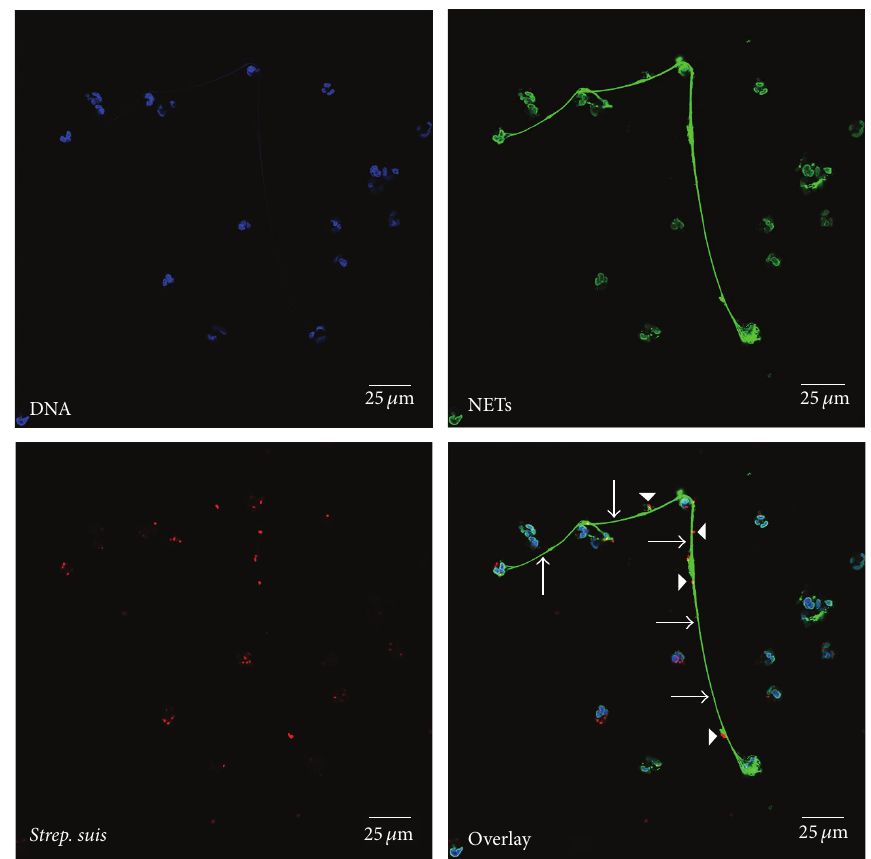
Figure 1: NETs entrapping Streptococcus (Strep.) suis Δ endAsuis Δ ssnA . Immunofluorescence microscopy analysis of NETs released by human neutrophils 4 h after infection with the DNase deletion mutant Strep. suis Δ endAsuis Δ ssnA in vitro [25]. Neutrophils and bacteria were centrifugedonpoly-L-lysine-coatedcoverslipsandthenucleiwerestainedwithHoechst(blue).Furthermore,thesampleswereincubatedwith a mouse monoclonal antibody against DNA/histone 1 (green, arrows) visualizing long extracellular fibres of released NETs and rabbit anti- Strep. suis antibody to label entrapped Strep. suis (red, arrowheads). The secondary staining was performed with goat anti-mouse Alexa 488- conjugated antibody and goat anti-rabbit Alexa 633-conjugated antibody. The coverslip was embedded in Prolong (cid:2) Gold antifade. Samples were recorded using a Leica TCS SP5 confocal inverted-base fluorescence microscope with a HCX PL APO 40x 0.75–1.25 oil immersion objective. Settings were adjusted with control preparations using a respective isotype control